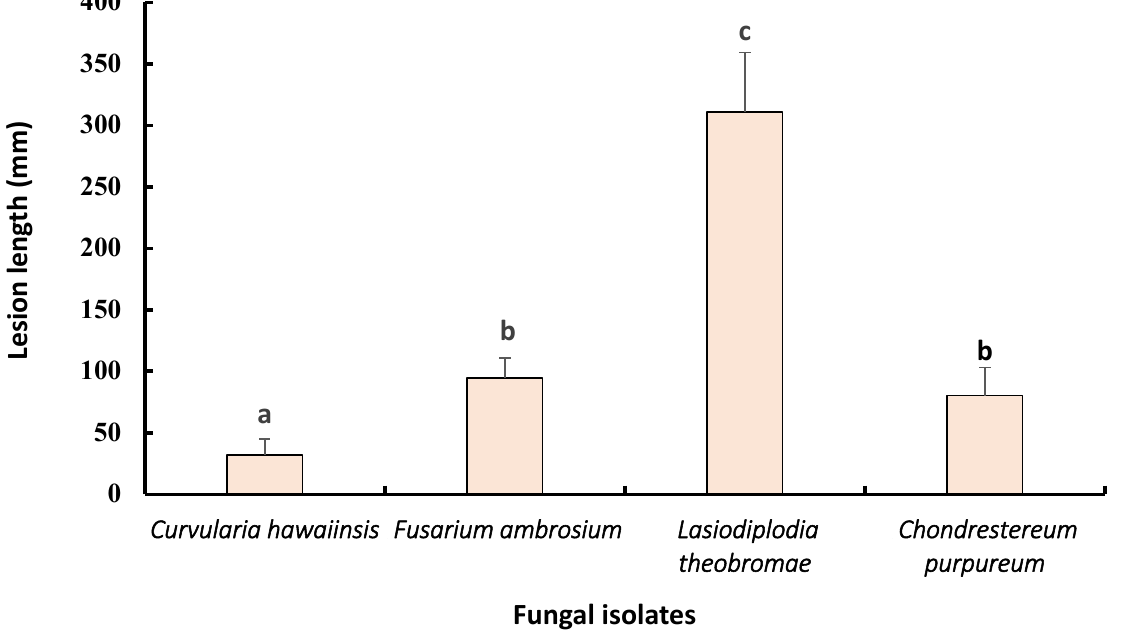
Figure 9. Mean lesion length caused by four fungal species in almonds two weeks after inoculation. Mean lesion length is based on six replicates. Means followed by the same letter are not significantly different ( p < 0.05). Bars represent the standard error of the